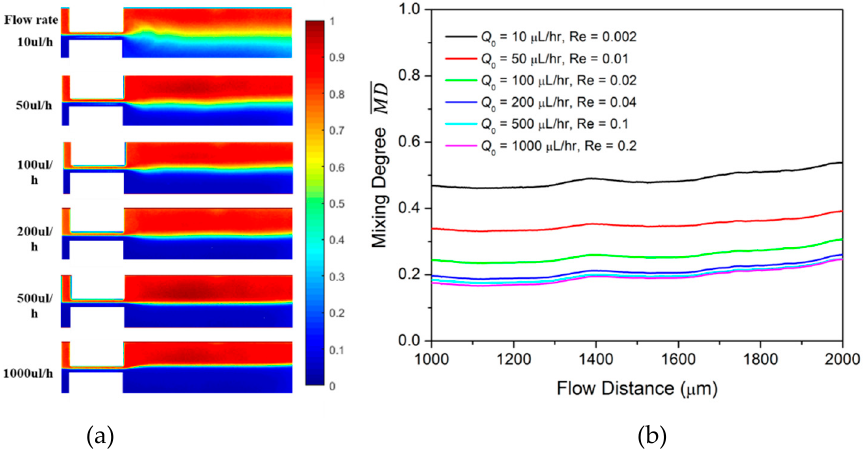
Figure 2. ( a ) Concentration profile of Newtonian fluid at different constant flow rates; ( b ) the averaged mixing degree MD at di ff erent constant flow rate